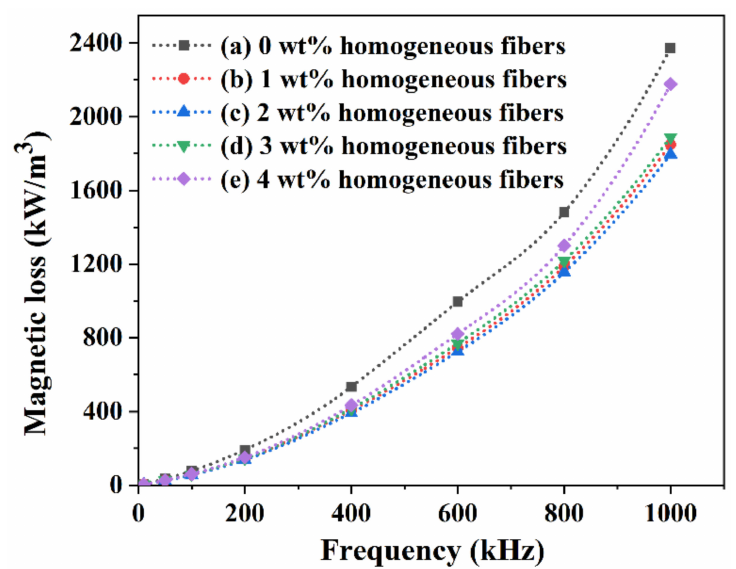
Figure 4. Magnetic loss of the homogeneous-fiber-reinforced MnZn ferrite samples versus frequency at room temperature: (a) 0 wt%, (b) 1 wt%, (c) 2 wt%, (d) 3 wt%, and (e) 4